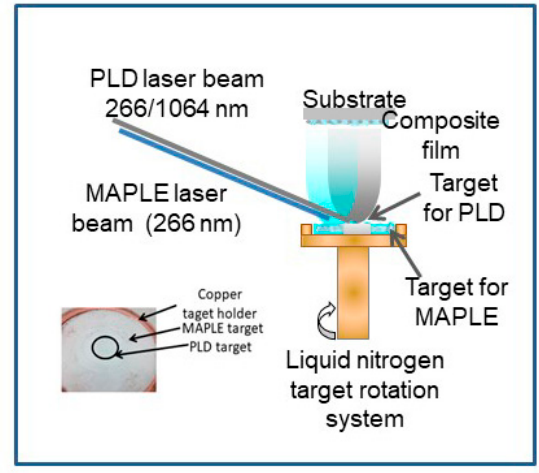
Figure 1. Experimental setup (combined matrix-assisted pulsed laser evaporation and pulsed laser deposition (MAPLE-PLD)) for thin films deposition. Table 1. The codes used for the films and their corresponding deposition conditions.